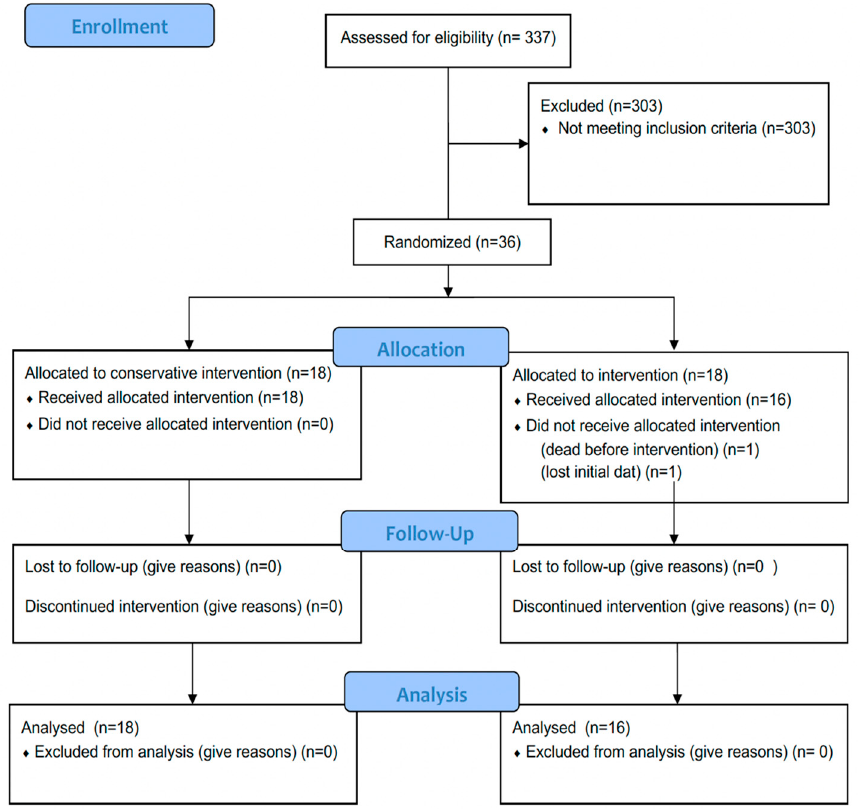
Figure 1. Diagram illustrating the flowchart regarding assessment, randomization, allocation, follow-up, and final analysis of study patients.